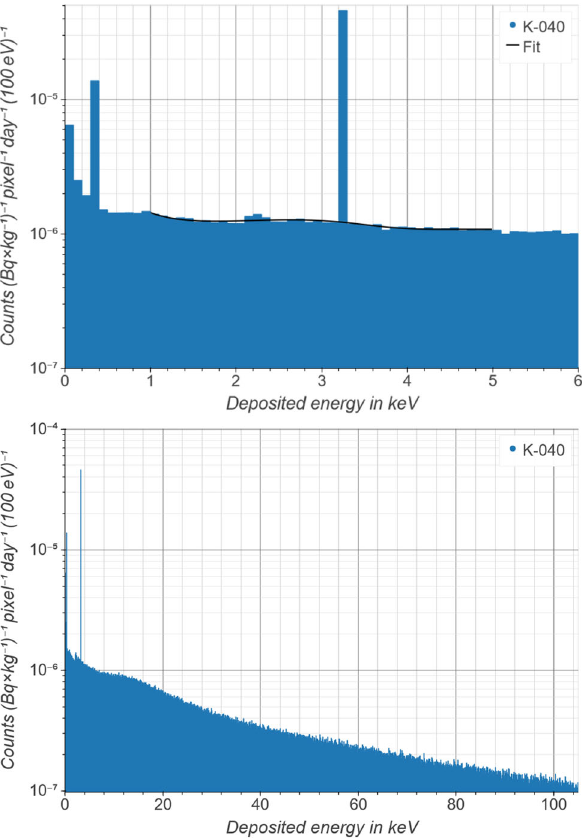
Fig. 6 Simulated spectrum of deposited energies in the MMC absorberscausedbythebulk-distributed 232 Th-chainasintheabsorbers. The fractions due to the single nuclides of this chain are colored. The α -particles can be emitted by any isotope. No special structures can be observed for low energies. At higher energies, the 228 Ra gamma levels at 6.5keV, 20keV and 33keV can be identified, as well as the 58keV level of the decay of 228 Ac